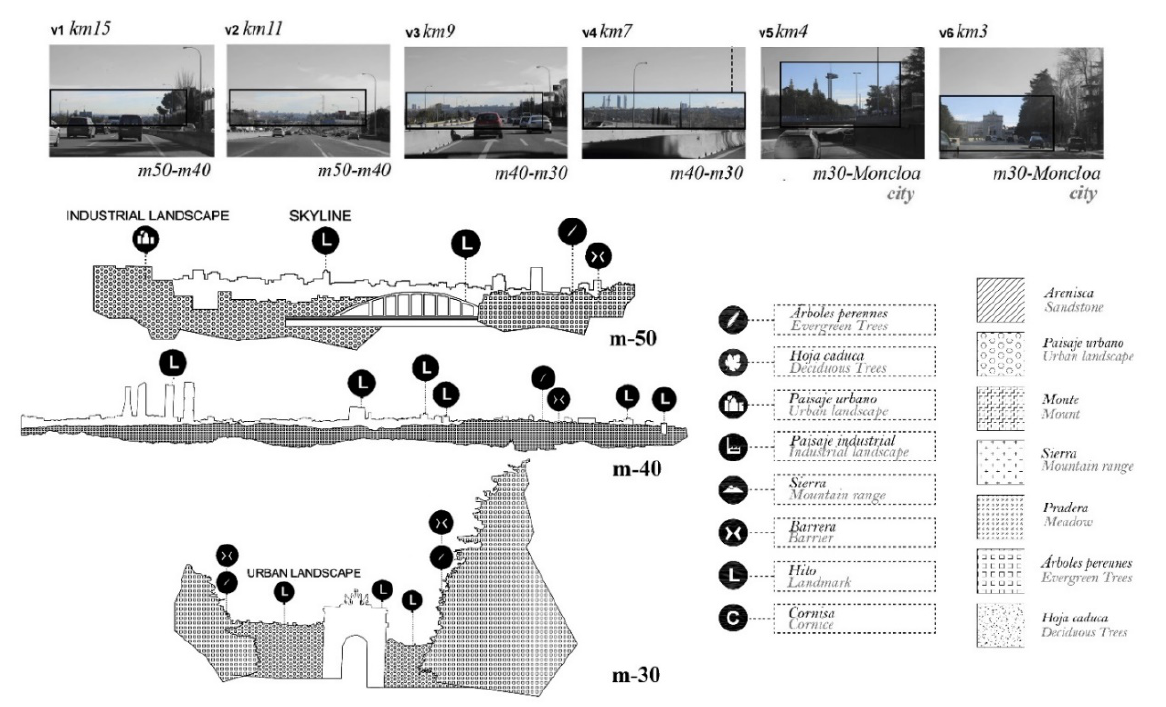
Figure 10: Selected frames and interpretive drawings from the analysis throughout the A6 road to